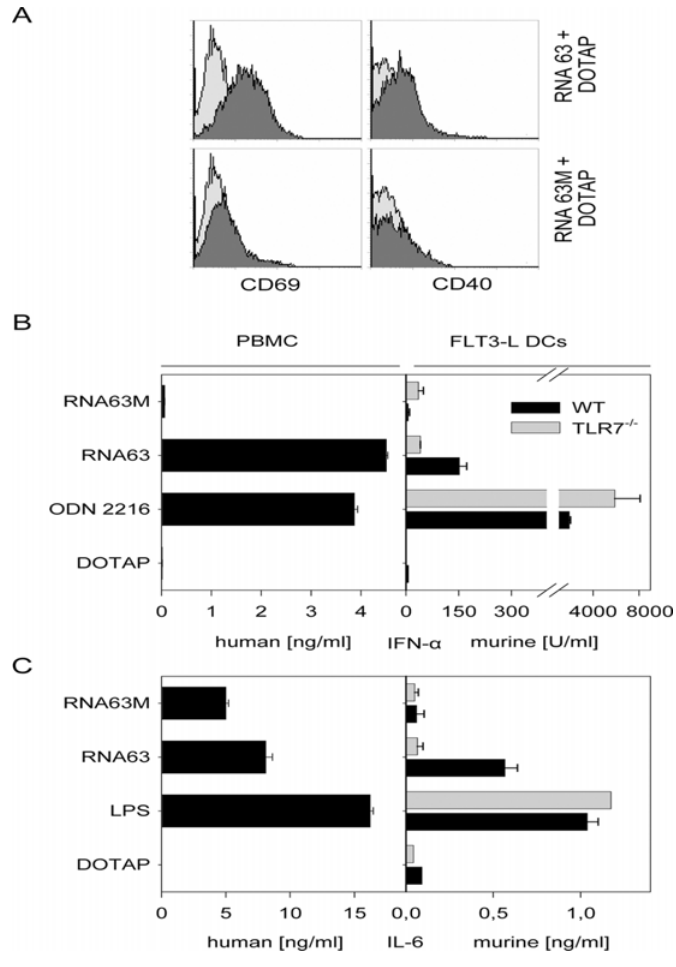
Fig 1. Differential induction of activation markers and cytokines by non-modified and 2 ’ -O-methylated synthetic RNA. (A) Murine FLT3L-DCs were stimulated with RNA63 or RNA63M complexed to DOTAP (dark grey) and stained for CD69 or CD40 as indicated. Unstimulated cells (same histogram data for both RNA stimuli) served as negative control (light grey). (B, C) Human PBMC (B) and murine WT or TLR7-deficient FLT3-L induced DCs (C) were stimulated with RNA63 (2 μ g/ml), RNA63M (2 μ g/ml) and ODN2216 (1 μ g/ml) or LPS (100 ng/ml) and IFN- α or IL-6 measured by ELISA after incubation for 20 hours. For panel A, B and C one representative experiment of at least three independent experiments are shown (n = 2 ±